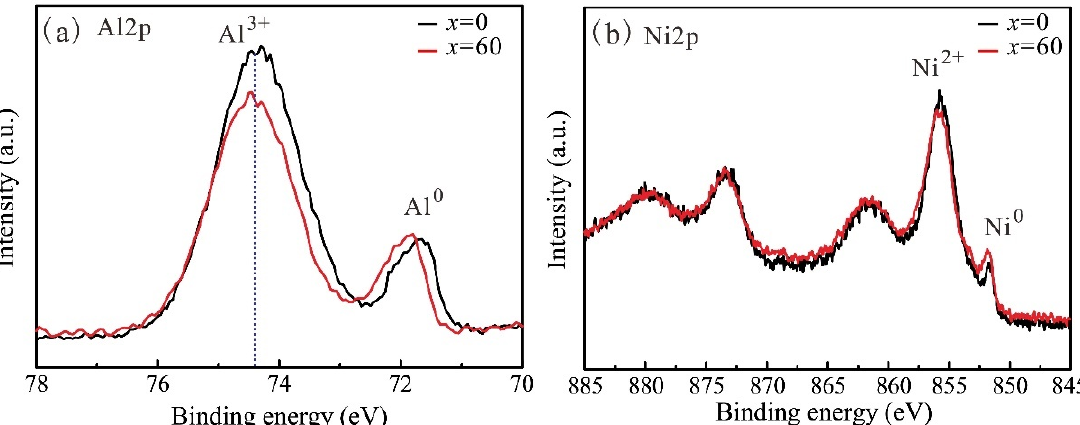
Figure 3. XPS patterns of Al2p 3/2 and Ni2p 3/2 spectra of (48Al–52Ni) 40 W 60 composites at room temperature. ( a ) Al2p 3/2 ; ( b ) Ni2p 3/2 .